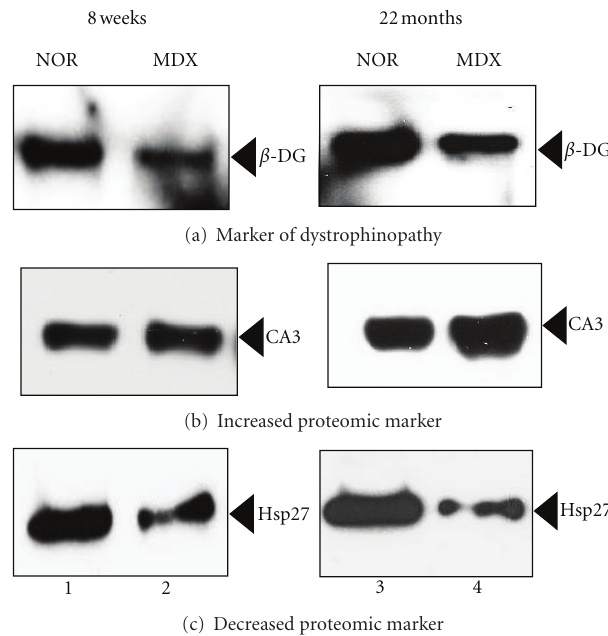
Figure 4: Immunoblot analysis of novel marker proteins in normal versus mdx tibialis anterior muscle during aging. Shown are repre- sentative immunoblots with expanded views of antibody-decorated protein bands. Panels (a, b, c) were labeled with antibodies to the dystrophin-associated glycoprotein β -dystroglycan ( β -DG), the CA3 isoform of the fibre type-specific enzyme carbonic anhydrase, and the molecular chaperone Hsp27, respectively. Lanes 1 and 2, and lanes 3 and 4, represent 8 weeks versus 22 months old normal wild type versus dystrophic mdx tibialis anterior muscle, respectively. Immuno-decorated protein bands are indicated by